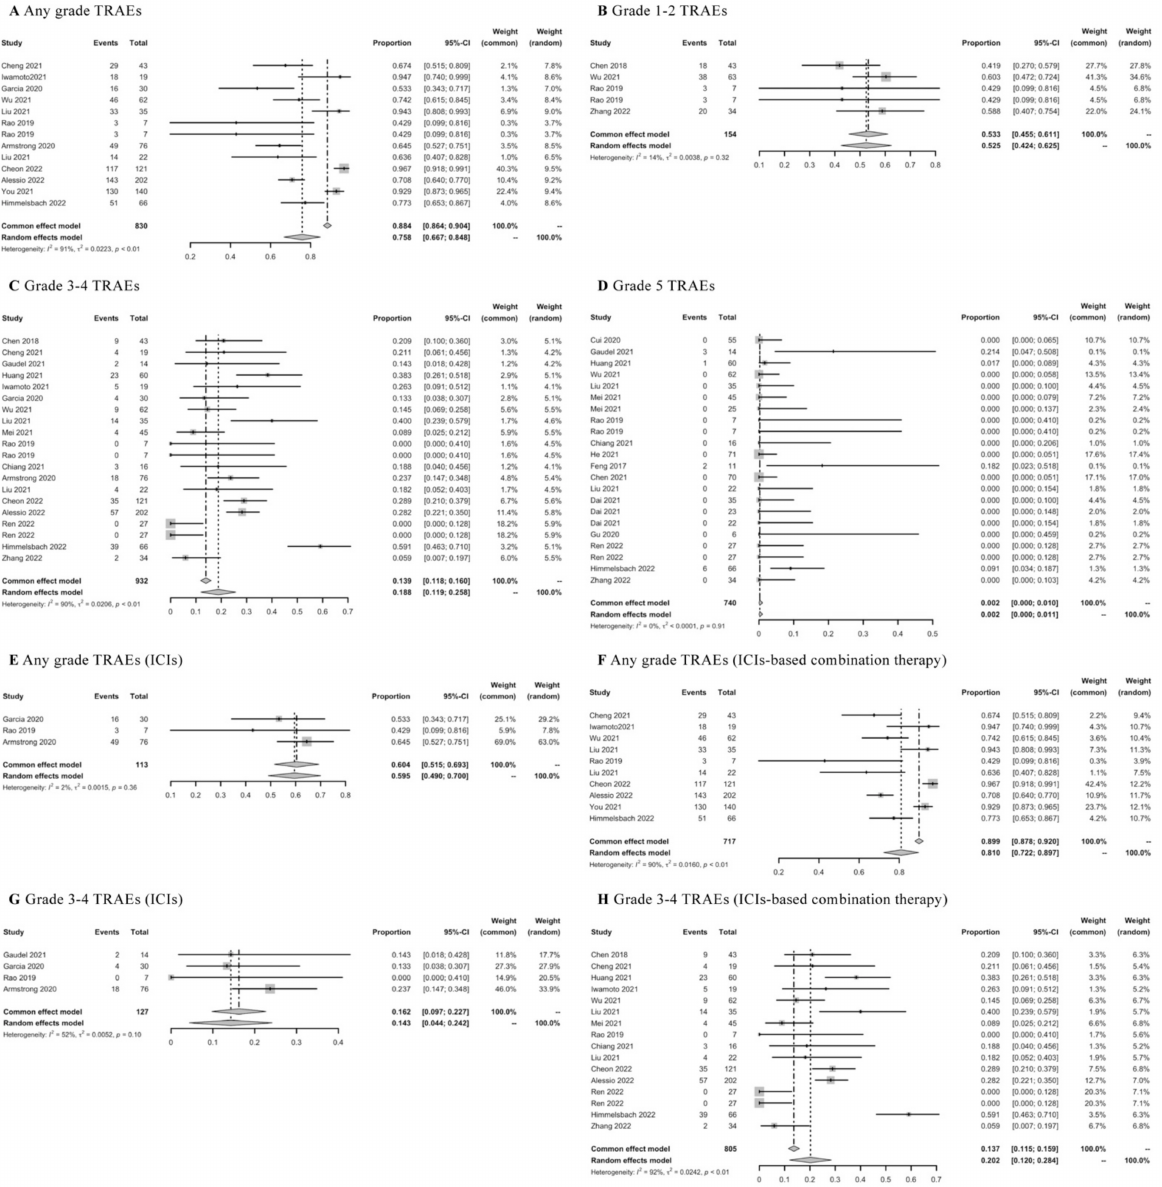
Figure 8. Meta-analysis of TRAEs in advanced HCC patients receiving first-line ICIs-based